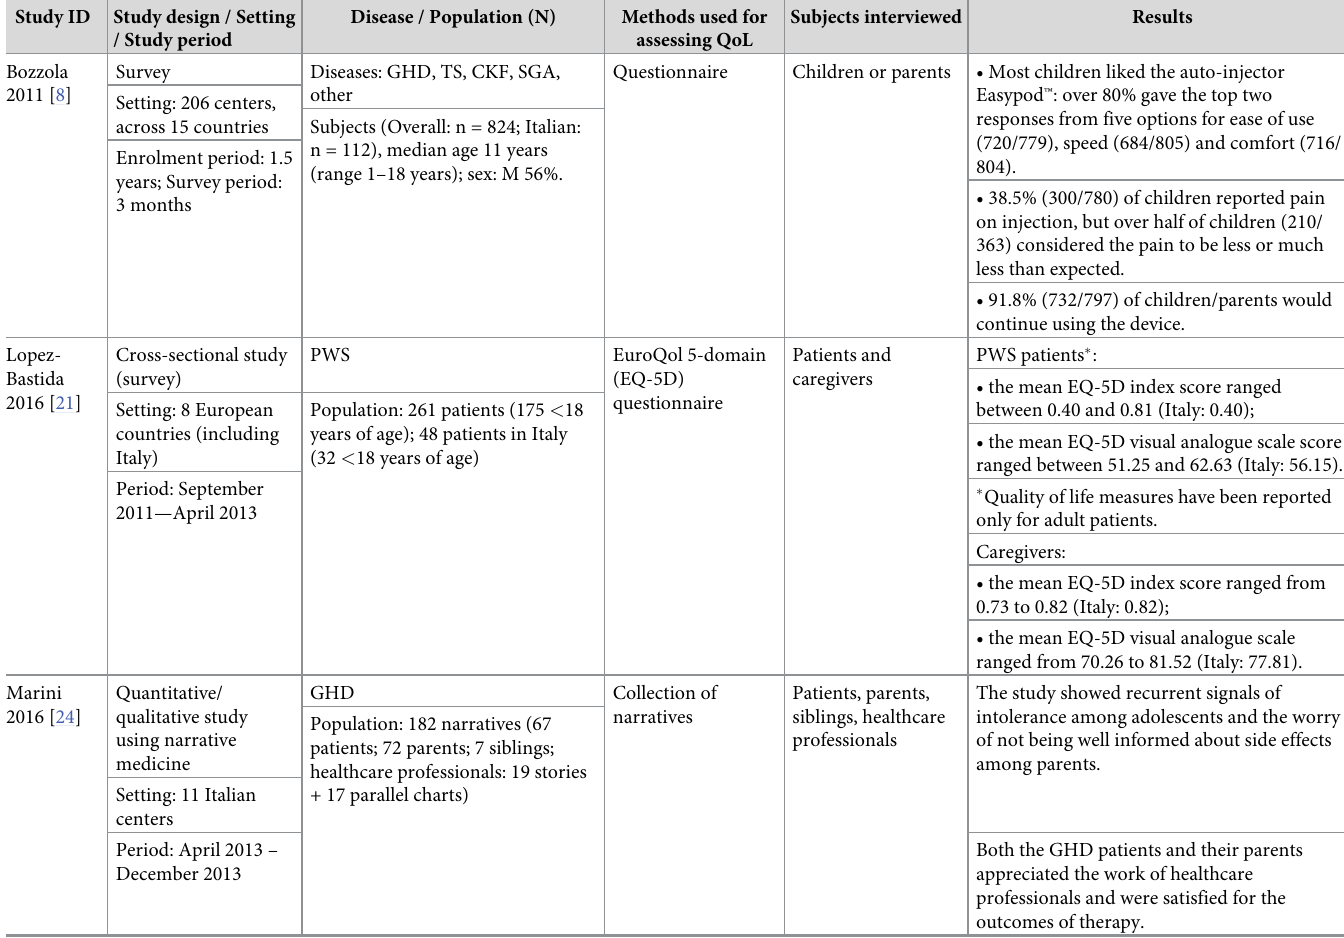
Table 5. Characteristics of included studies for quality of